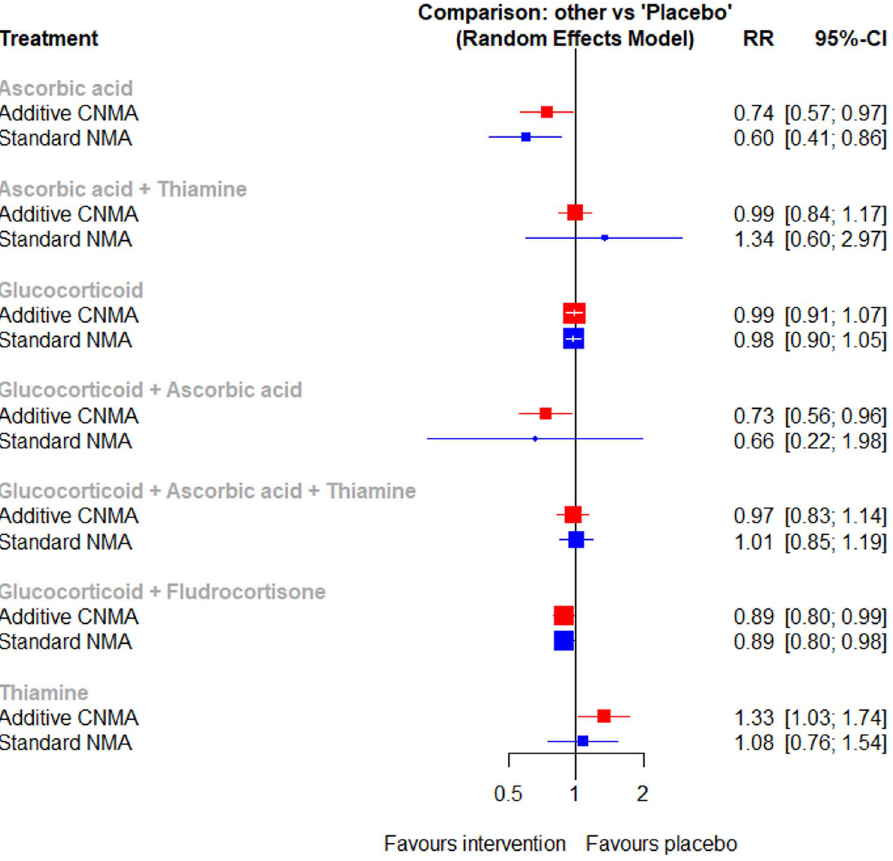
Figure 1. Network meta-analysis on short-term mortality (< 90